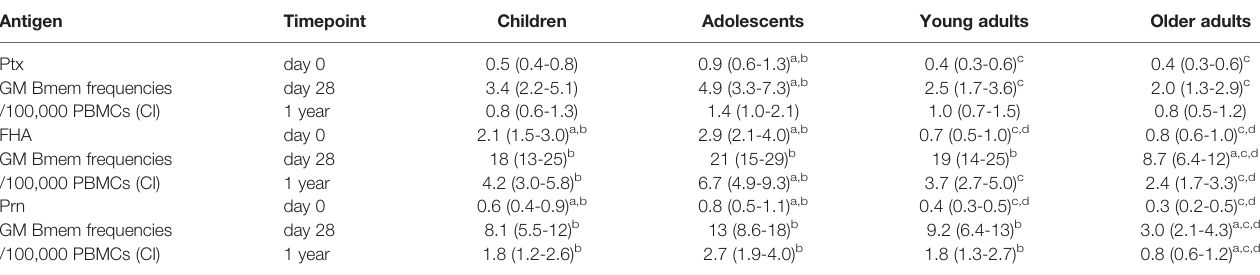
TABLE 2 | Antigen speci fi c geometric mean memory B cell frequencies per age group with 95% con fi dence intervals and signi fi cances from all countries together were calculated using a linear mixed model on the log10 transformed data taking the longitudinal structure into